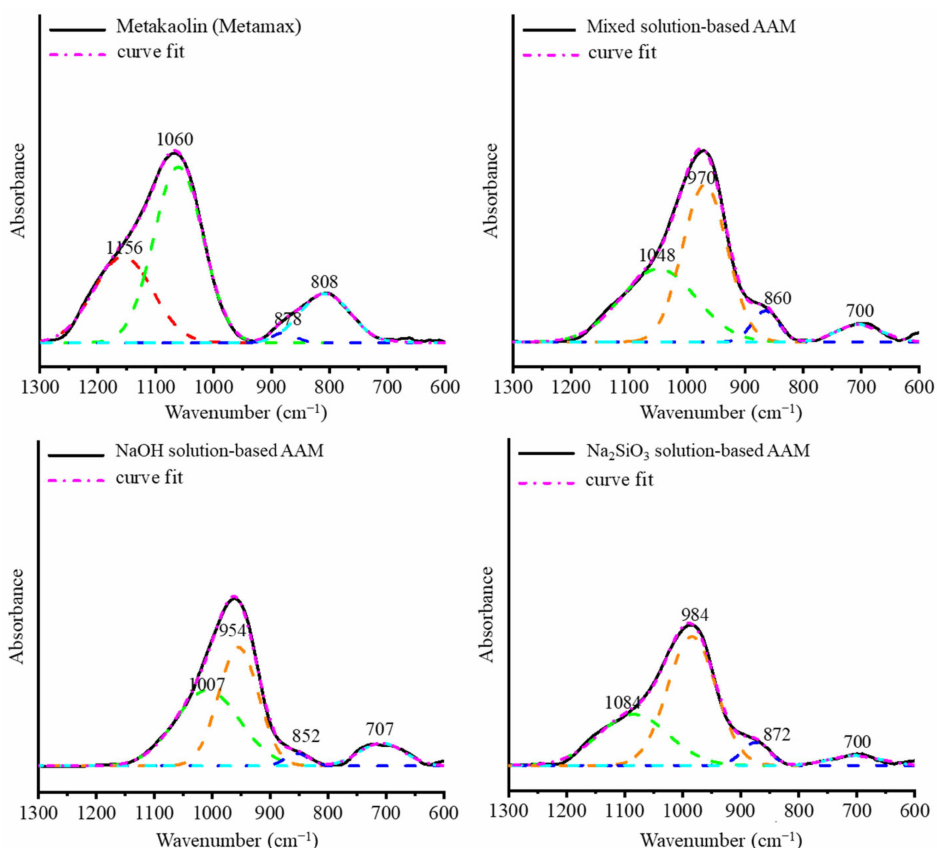
Figure 6. Deconvolution of the main band (1300–600 cm − 1 ) of metakaolin and AAM powders with different alkali activators.